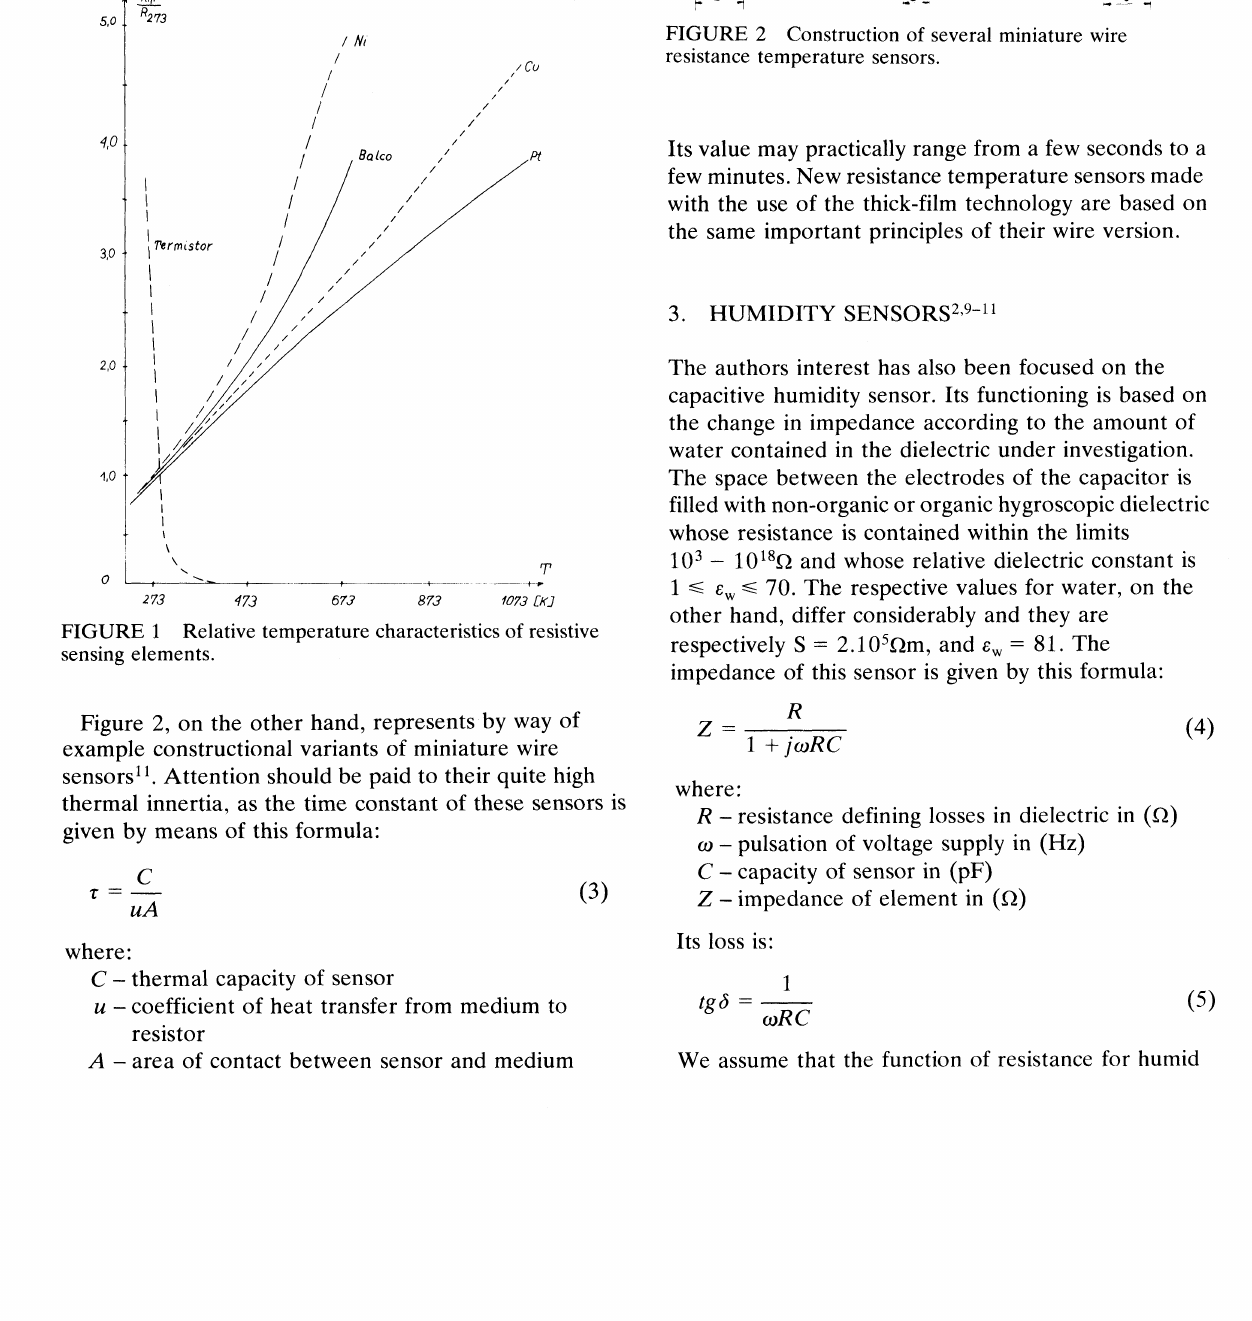
FIGURE 2 Construction of several miniature wire resistance temperature